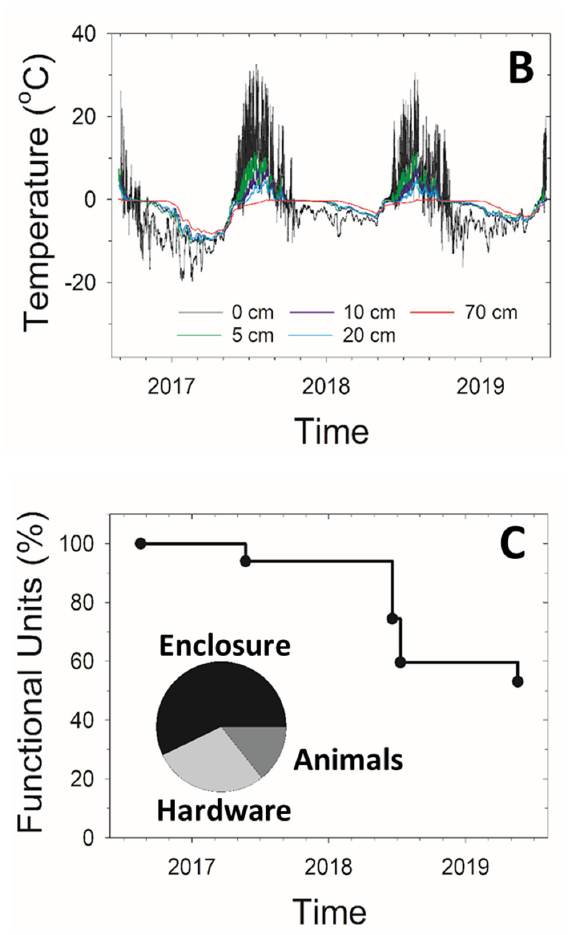
Figure 2. ( A ) Laboratory cross-validation between an Onset HOBO Pro v2 external temperature data logger (U23-003) and the DIY soil temperature data logger. Half hourly averages are shown to minimize thermal disequilibrium and differences in sensor response time. ( B ) Plot of average site temperature at five depths from our field test on the North Slope of Alaska. ( C ) Plot of the percentage of DIY soil temperature data loggers still functional based upon the data recorded versus time from our field test on the North Slope of Alaska. The inset pie chart depicts the causes of data logger